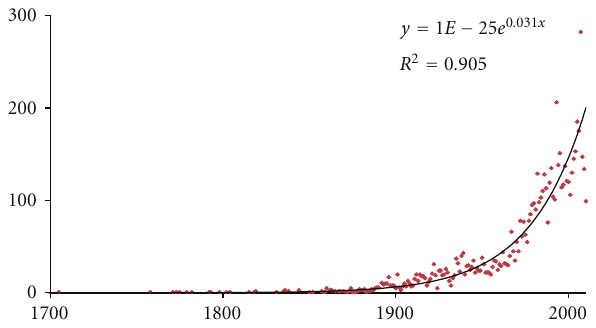
Figure 1: The exponential spread of papers containing the words Acromyrmex , Atta, or Attini in the title, abstract, or key words ( n = 6,561). The regression is calculated for the period from 1850–2010. Although the tribe is not exclusively Neotropical, we estimate an annual output of 300 leaf-cutter ants papers by 2020. Formis 2011 [15].